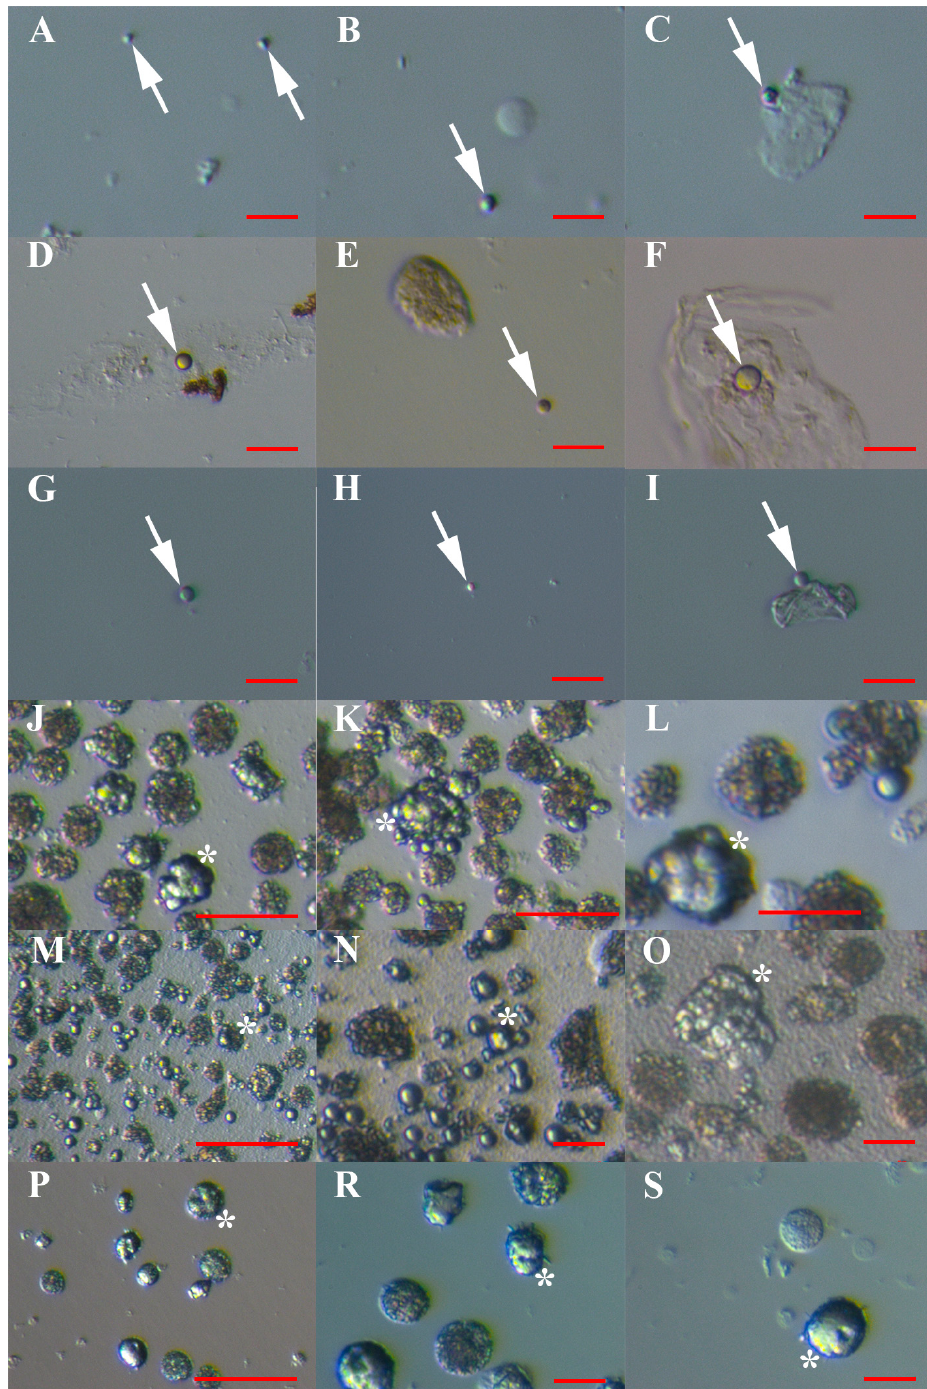
Figure 8. VSEL-like stem cells (arrows) with diameters of up to 5 μ m and cell clusters (asterisk) after CD133-based magnetic-activated cell sorting (MACS). ( A – I ): Just after MACS sorting: human embryonic stem cells (hESCs) (A–C), normal ovary cells (D–F) and recurrent ovarian cancer ascites (G–I); ( J – S ) after artificial activation with valproic acid and FSH: human embryonic stem cells (hESCs) microscope (Hoffman illumination). Red bar: 10 μ m for A–I, L, N, O, R, S; 50 μ m for J, K; 100 μ m for M, P.